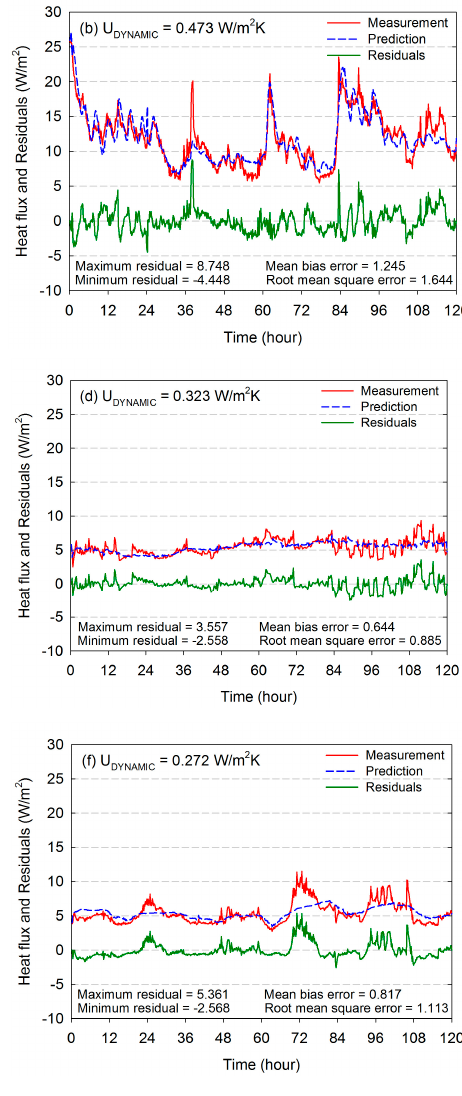
Figure 7. ( a ) (cid:1847) -values; (b ) their percentage deviations estimated by calculation method, progressive average method, and dynamic method.